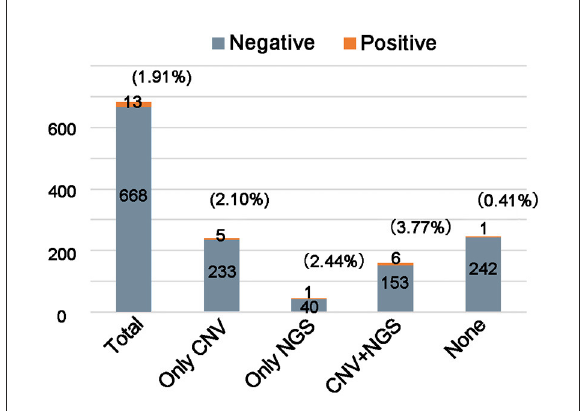
FIGURE2 Comparison of the yield of fragile X testing in unknown etiology ID/GDD patients with or without genetic examination. The number of individuals analyzed is shown in each